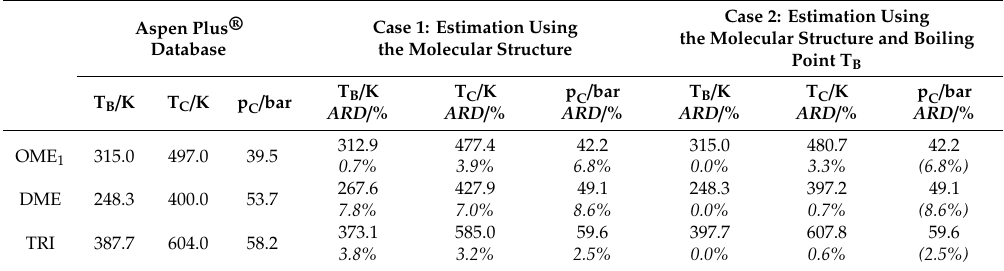
Table 4. Comparison of critical component properties from Aspen Plus ® databases with the built-in predictive models. Case 1: Estimation Using the Molecular